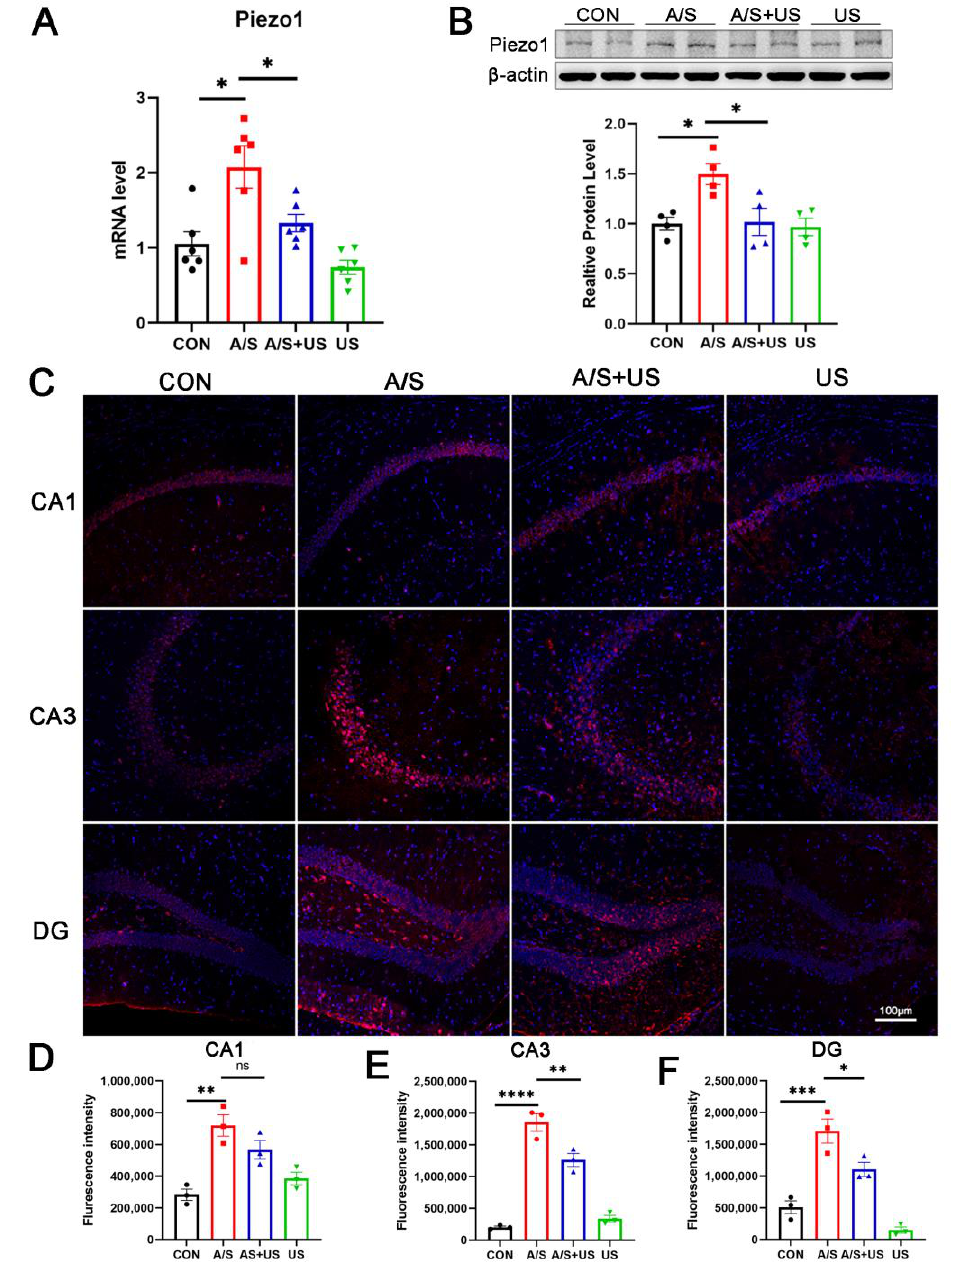
Figure 5. LIPUS inhibits Piezo1 expression after anesthesia/surgery in aged mice. ( A ) The mRNA expression of Piezo1 was qualified by RT-qPCR among the four groups ( n = 6 per group). ( B ) Western blotting detection of Piezo1 among the four groups ( n = 4 per group). ( C ) Immunofluorescence detection of Piezo1 expression in CA1 ( C , D ), CA3 ( C , E ), and DG ( C , F ) regions among the four groups ( n = 3 per group). Data were presented as Mean ± SEM. One-way ANOVA followed by Bonferroni’s multiple comparisons tests. * p < 0.05, ** p < 0.01, *** p < 0.001, **** p <